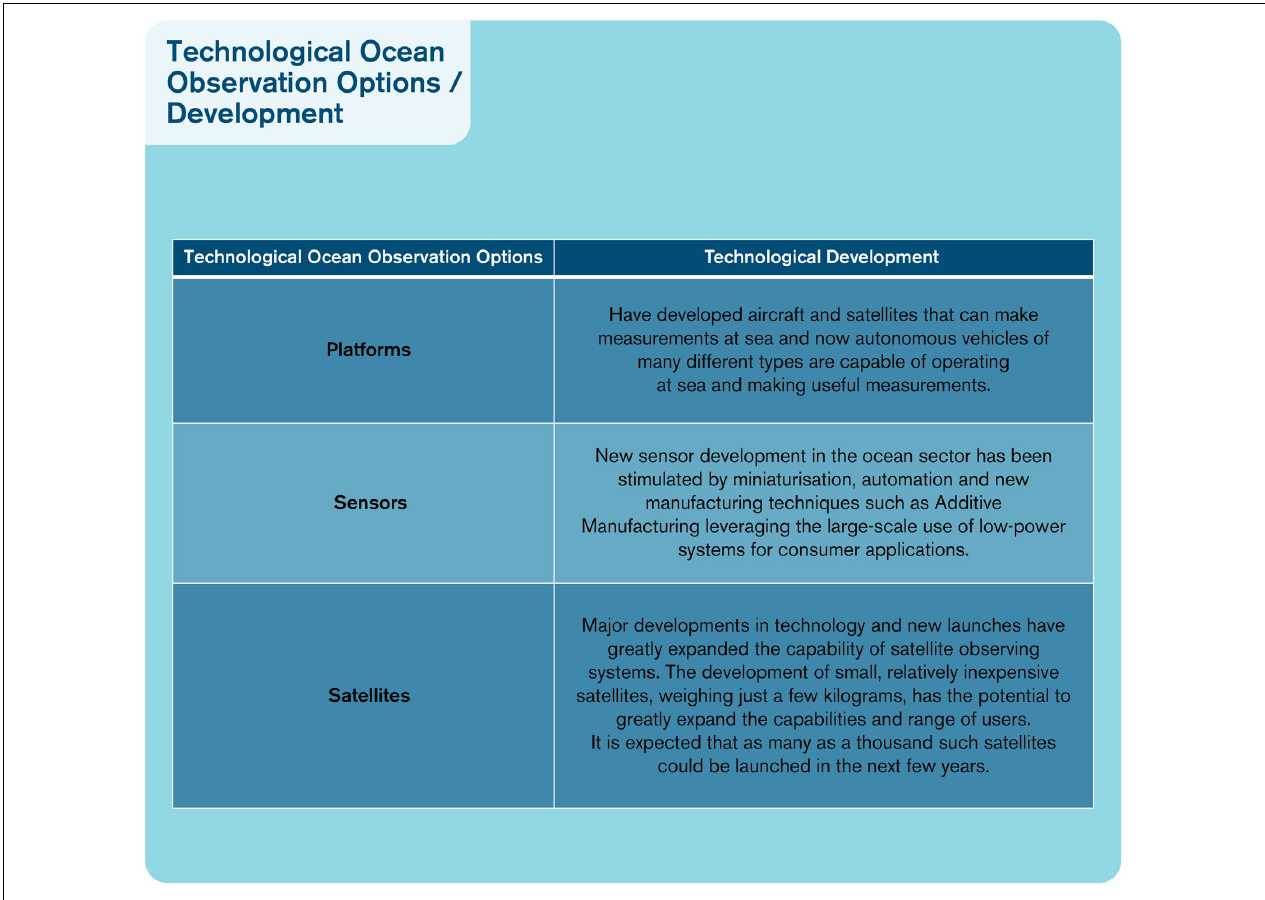
FIGURE 10 | Technological ocean observation options/development. Aspects of technological development leading to innovations in ocean